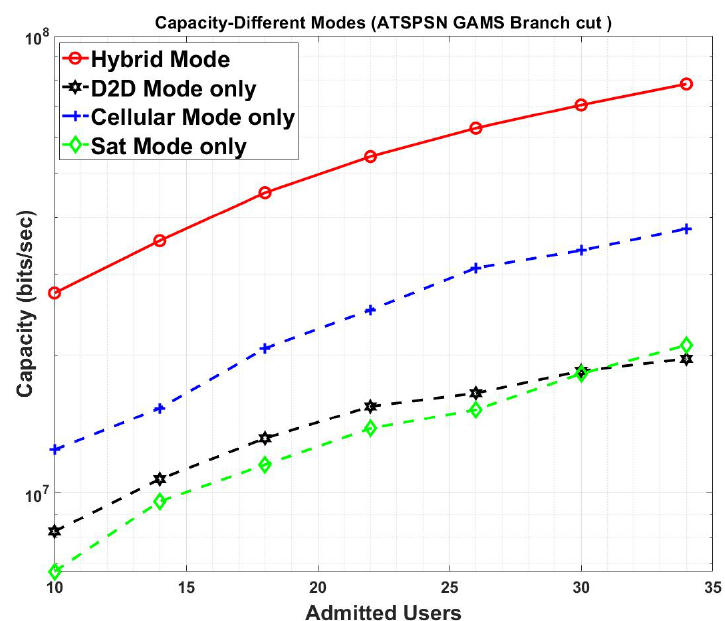
Figure 7. Capacity: Mode Analysis.